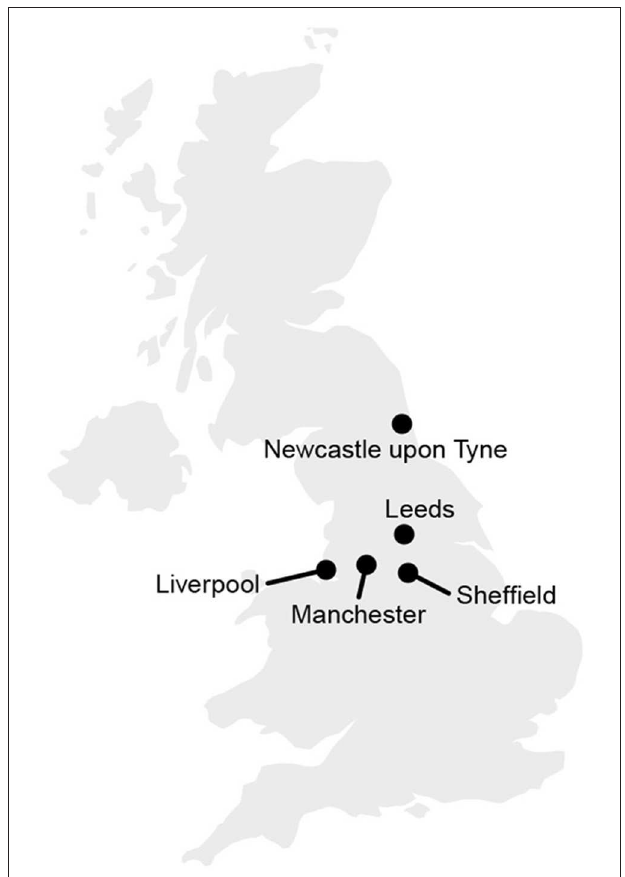
FIGURE 1 | Geographical location of the five selected